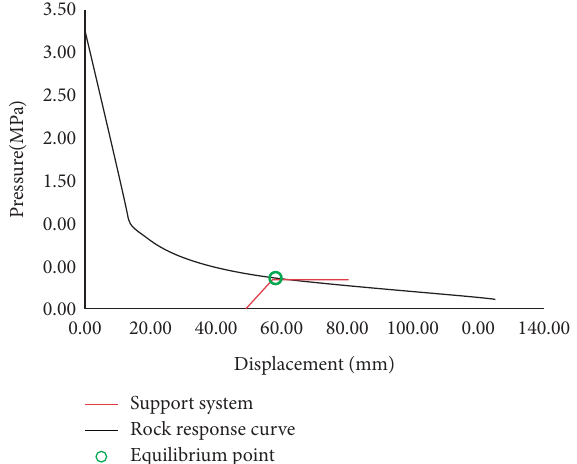
Figure 11: Rock-support interaction curve for the tunnel using the optimal combined support system.